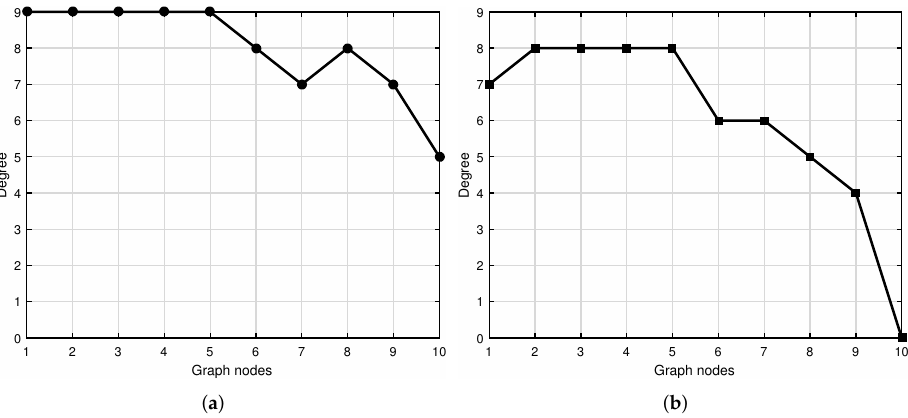
Figure 2. ( a ) Degree of the land clutter graph and ( b ) degree of the sea clutter